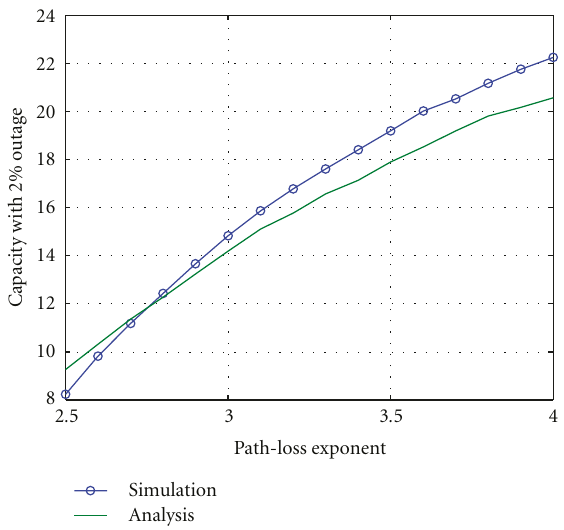
Figure 8: Probability density function of (1 /n ) and its Gaussian approximation (dotted line).